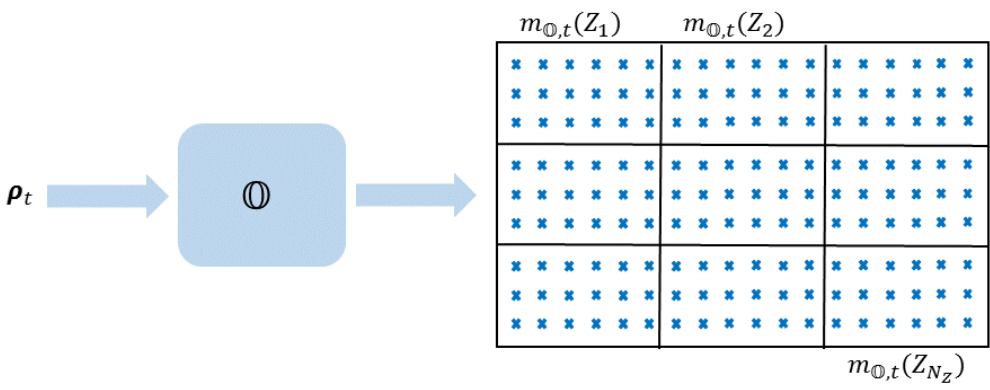
Figure 2. Illustration of the localization phase using the observation model O